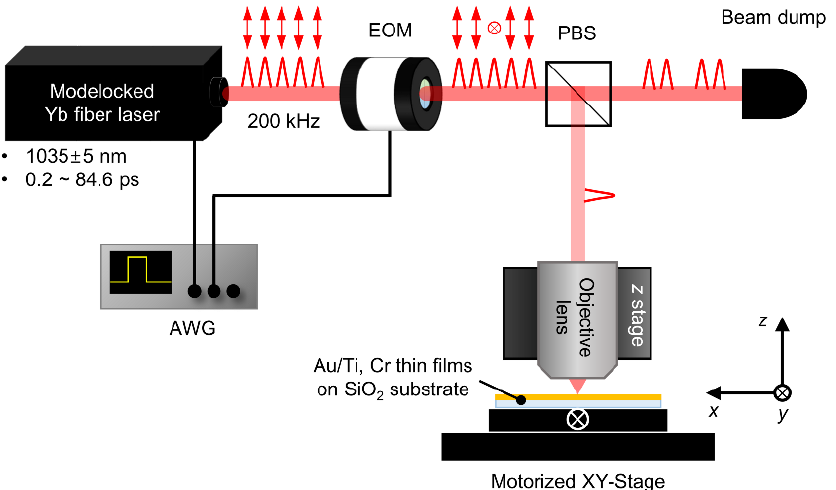
Figure 2. Schematic illustration of experiment setup. The laser pulse duration is adjusted in the range of 0.2 to 84.6 ps. Single-pulse picking is achieved through an electro-optic modulator (EOM) in combination with a polarizing beam splitter (PBS) and an arbitrary waveform generator (AWG). The metal thin film sample is positioned using a 3-axis motorized stage.